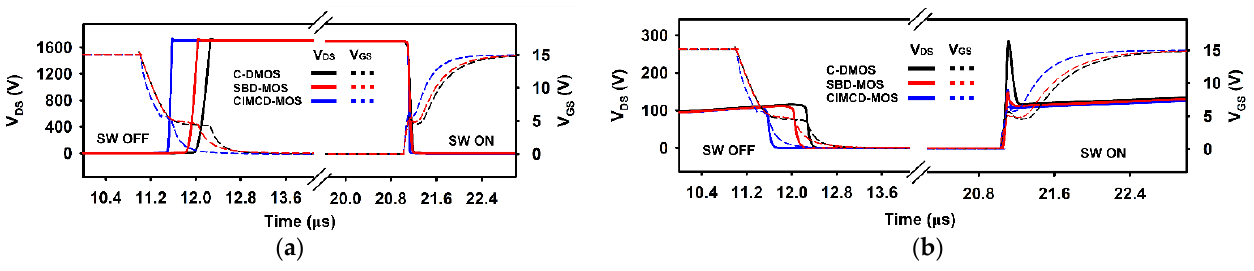
Figure 11. ( a ) Comparison of the ( a ) drain voltage switching waveforms and ( b ) drain current switching waveforms of C – DMOSFET, SBD – MOSFET, and CIMCD – MOSFET.